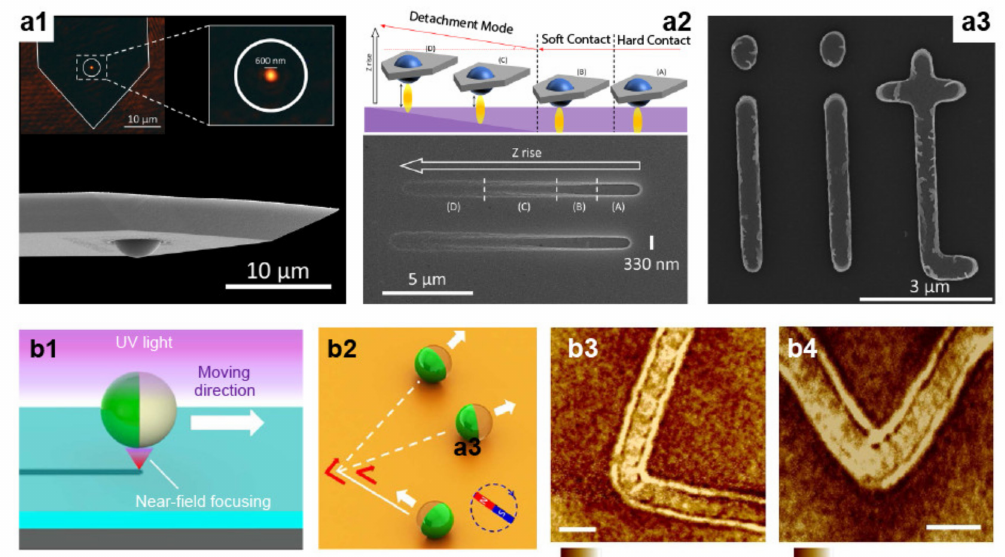
Figure 3. ( a1 ) Scanning electron micrograph of an AFM cantilever with a microsphere. The inset is an optical image of the laser-illuminated sphere with the nanojet clearly visible. ( a2 ) Schematic (top) and scanning electron micrograph (bottom) of out-of-plane scans. ( a3 ) Scanning electron micrograph showing the letters IIT created with scanning probe photonic nanojet lithography. Adapted with permission from [68] Copyright 2017 American Chemical Society. ( b1 ) Schematic showing a moving Janus microsphere motor near the photoresist surface under exposure to UV-light. ( b2 ) Illustration of the magnetic guidance of sphere motion. ( b3,b4 ) Patterns created by turning the magnetic field by 90 ◦ ( b3 ) and 120 ◦ ( b4 ). Scale bars 5 µ m. Adapted with permission from [71] Copyright 2014 Springer